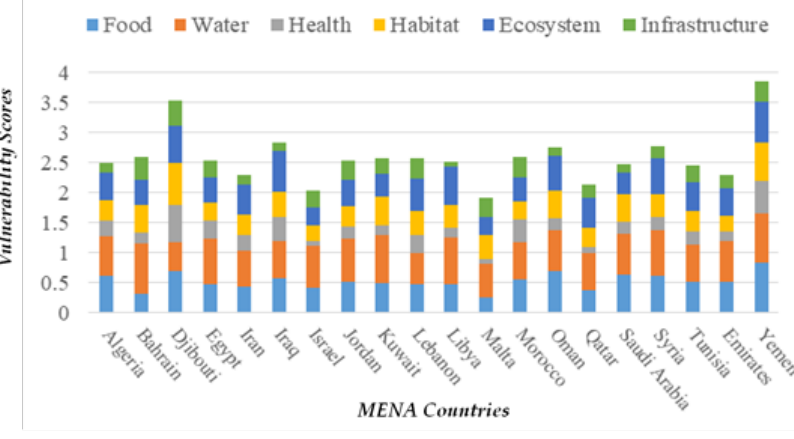
Figure 2. Vulnerability of Middle East and North Africa (MENA) countries to climate change .